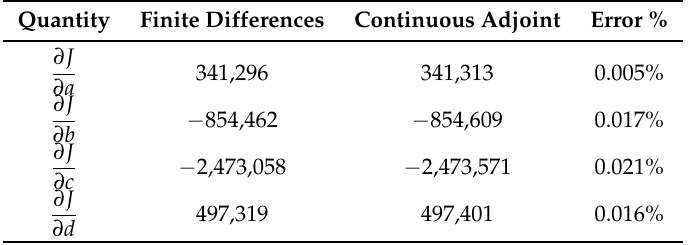
Table A2. Gradients from finite differences vs. gradients from the continuous adjoint for the baseline